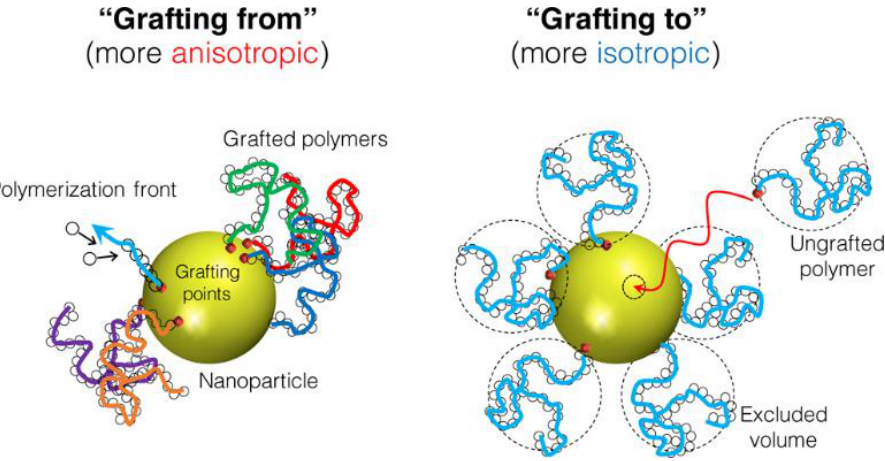
Figure 5. Surface coverage by “grafting from” and “grafting to” approaches. Reprinted with per- mission from ref. [106]. Copyright 2017 ACS. permission from ref. [106]. Copyright 2017